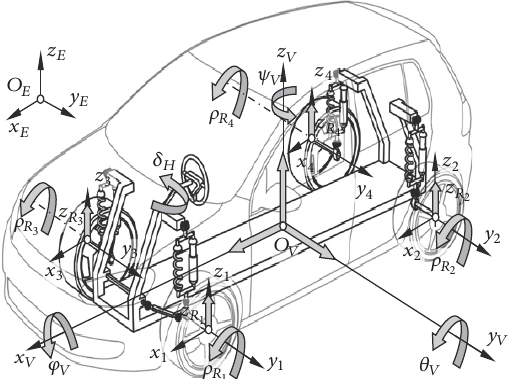
Figure 7: Degrees of freedom of the dual track model [20].